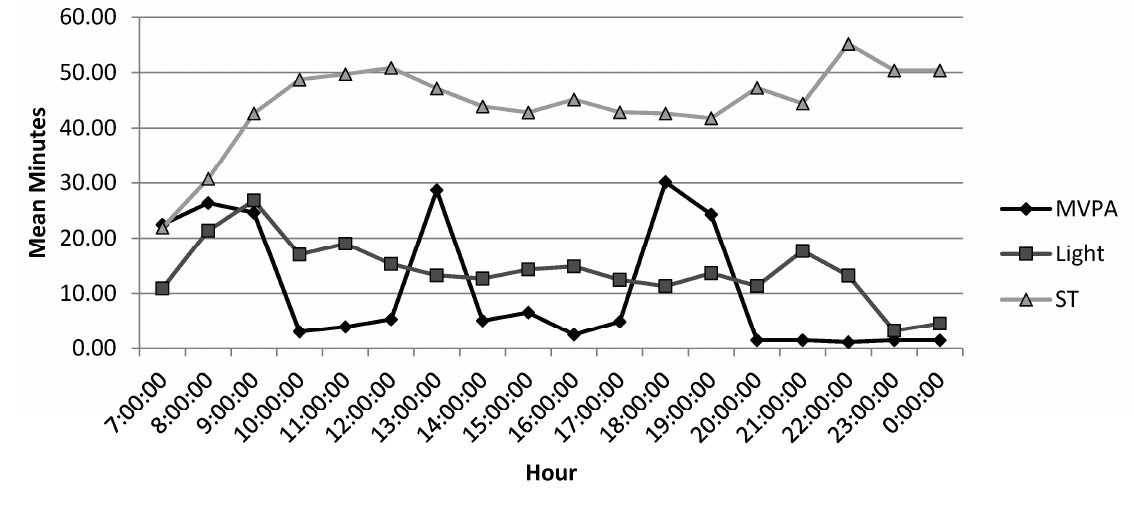
Figure 1. Mean daily ST, light intensity PA and MVPA for 24 South Asian women participating in qualitative